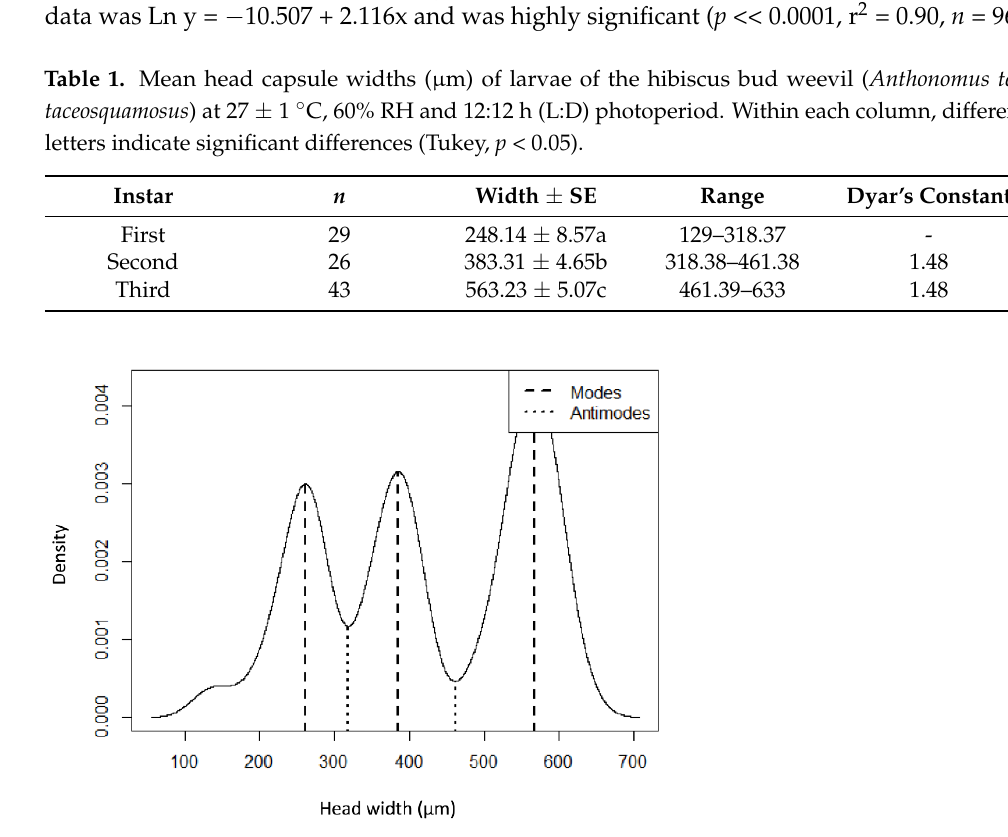
Figure 1. Density distribution of larval head capsule widths of the hibiscus bud weevil ( Anthonomus testaceosquamosus ). The graph presents the three unimodal peaks as estimated by the excess mass test as described in Ameijeiras ‐ Alonso [16]. Each peak represents a larval instar.